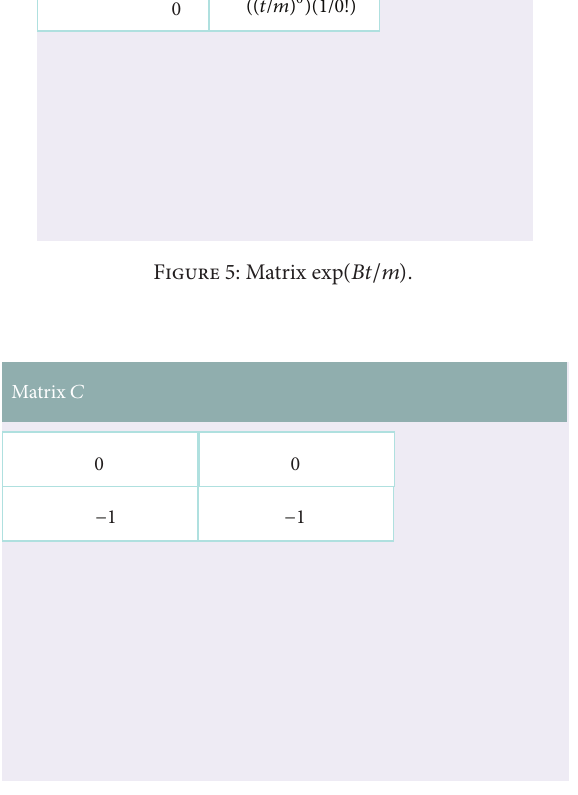
Figure 6: Matrix 𝐶 .